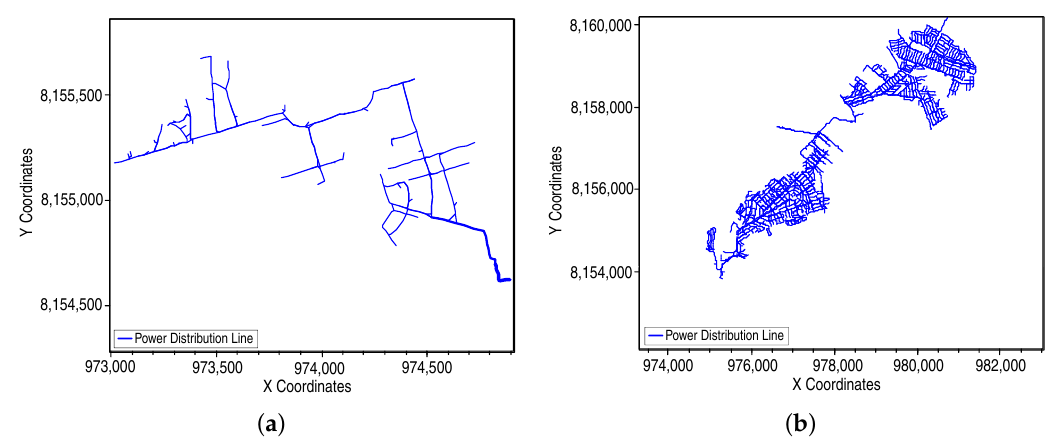
Figure 5. Mapping of distribution lines in feeders at Goiania Leste substation: ( a ) Feeder 14 and ( b ) Feeder 20.